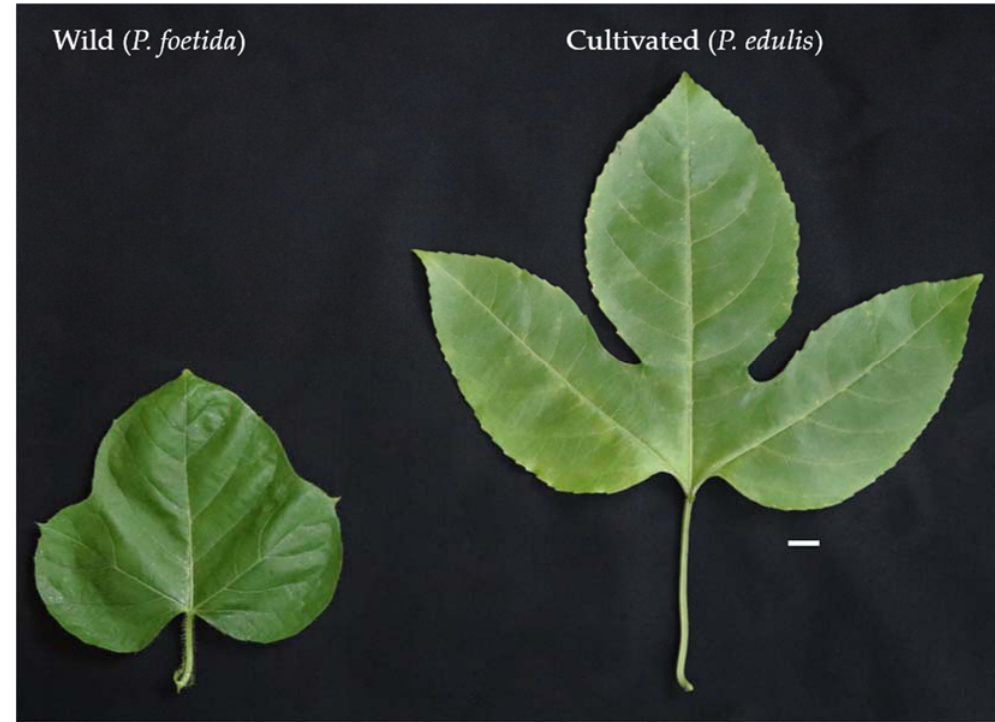
Figure 4. Leaf morphology in wild P. foetida and cultivated species P. edulis (scale bar = 1 cm). Note the differences in leaf size and the lobe incisions.